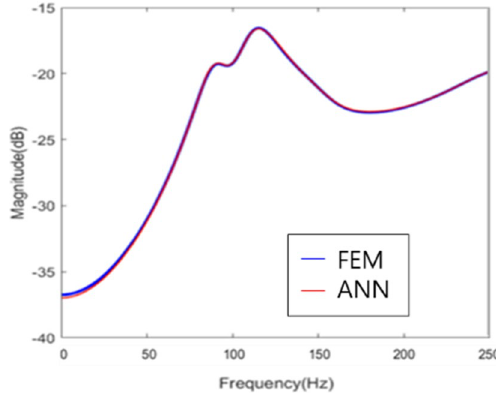
Figure 15. Blocked force prediction results.